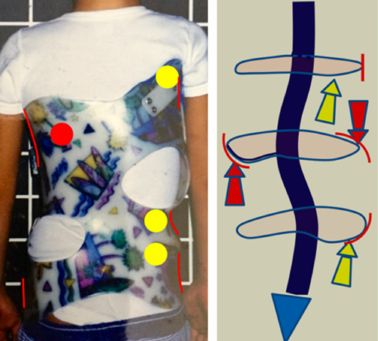
Figure 2. The brace design in a single thoracic scoliosis (Left convex in this EOS patient). One single mechanism of regional derotation (red arrows) works in combination with two counter-rotation forces (yellow arrows). Lateral, dorsal and ventral contacts are provided to guide frontal and sagittal plane alignment and